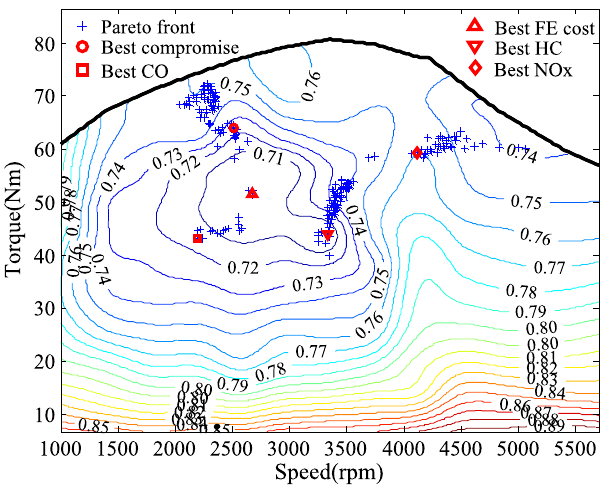
Figure 5. Distribution of the Pareto